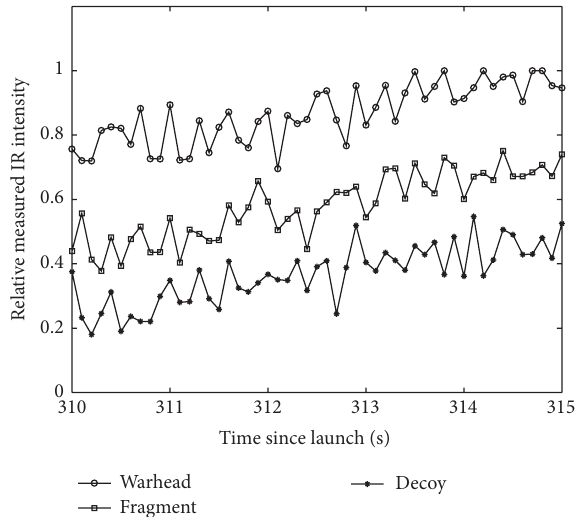
Figure 4: The intensity history for three types of exoatmospheric